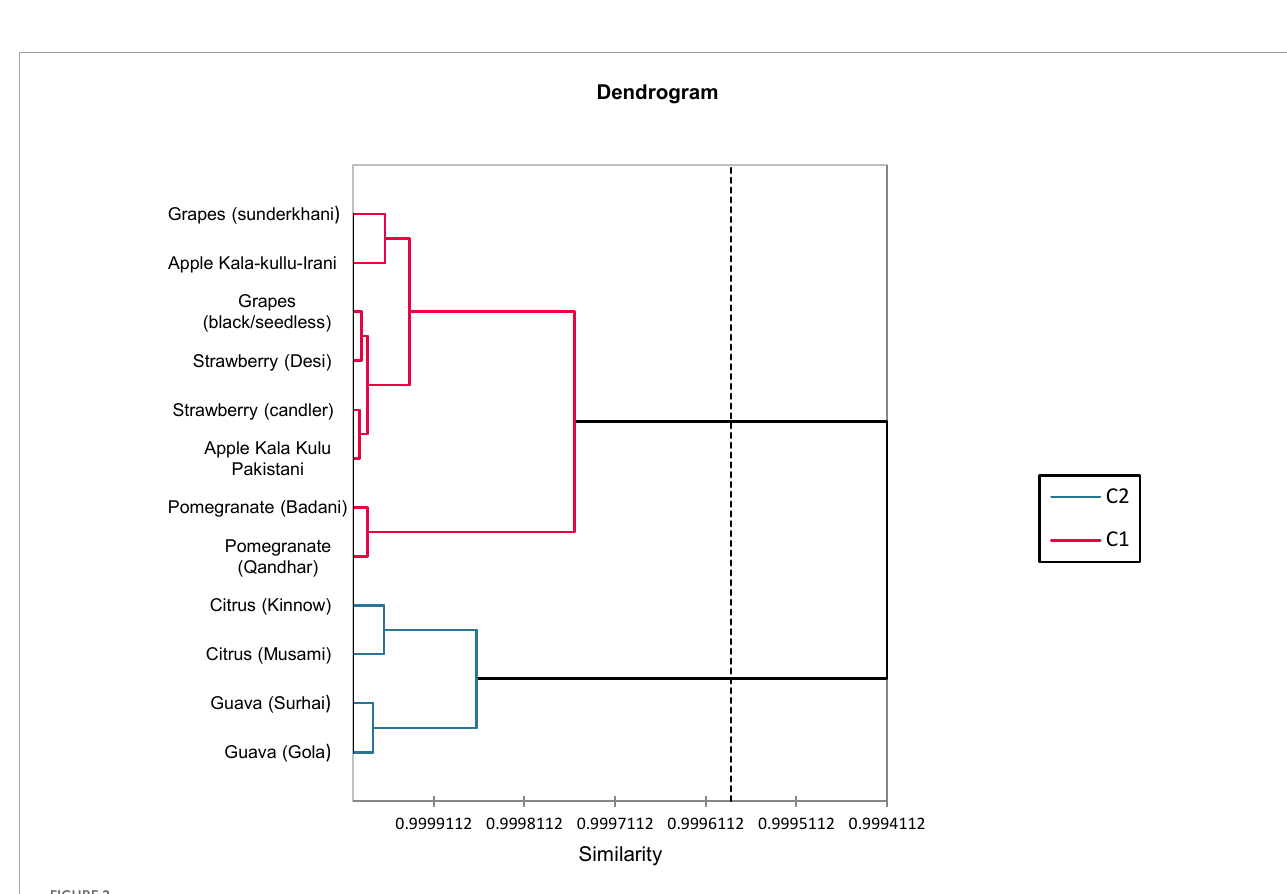
FIGURE2 Agglomerative hierarchical clustering (AHC) dendrogram of various fruit peel